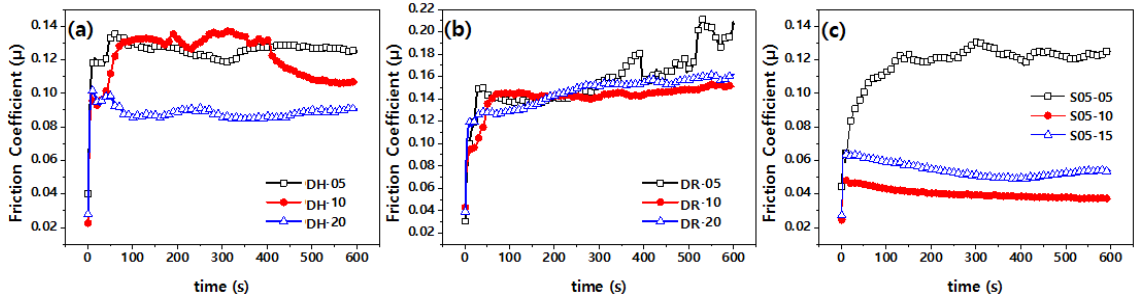
Figure 6. Friction coefficients of composites with different contents of graphene: ( a ) GH, ( b ) GR, and ( c ) S05.